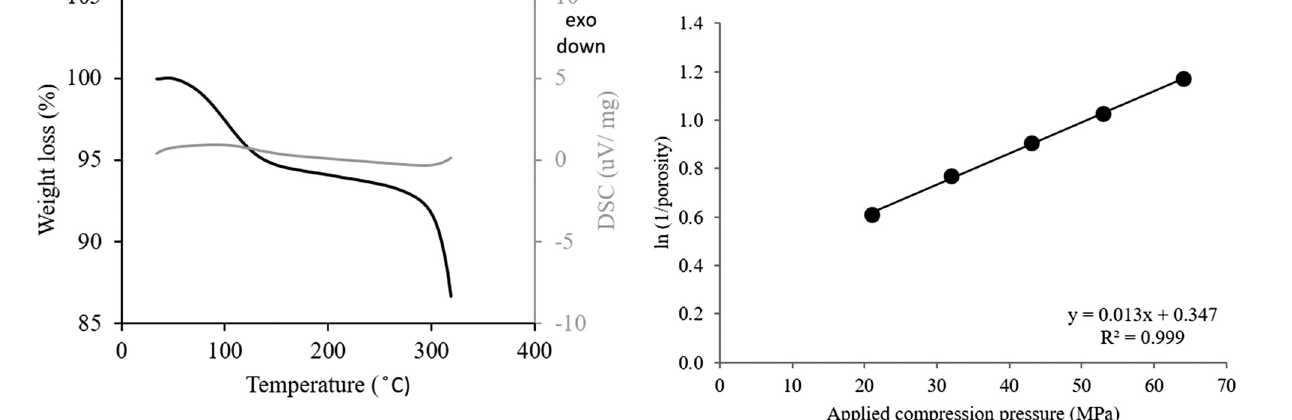
Figure 1: A representative plot of overlaid TGA - DSC analyses of MCC powder.